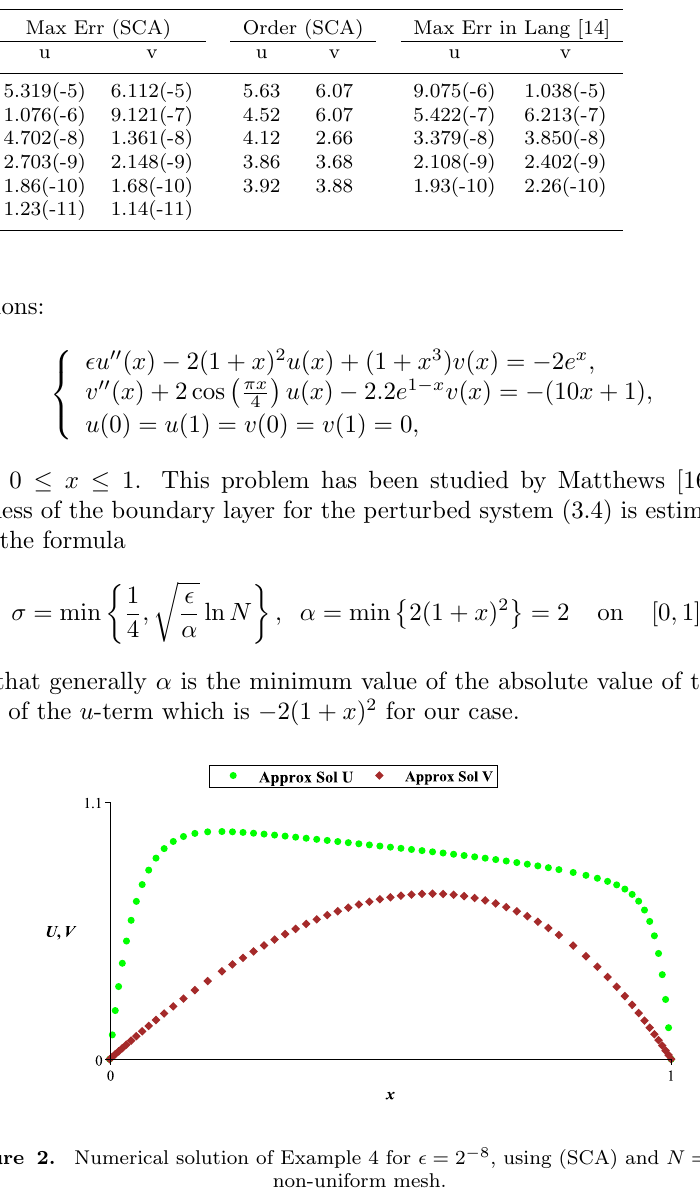
Table 3. Numerical solution of Example 3.